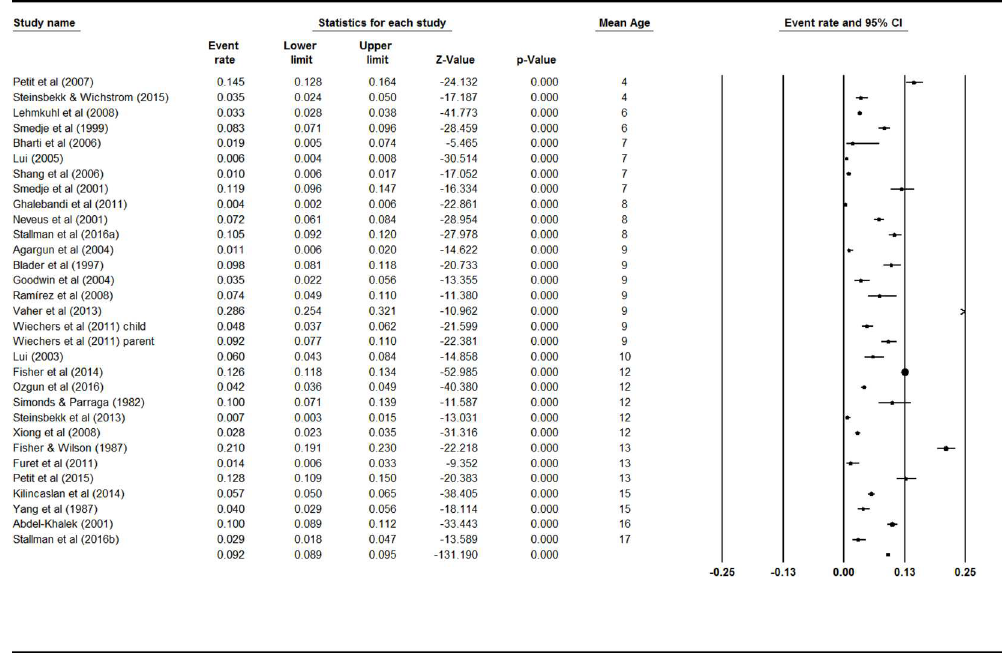
Fig 5. Forest Plot for child current sleepwalking prevalenceordered by mean sample